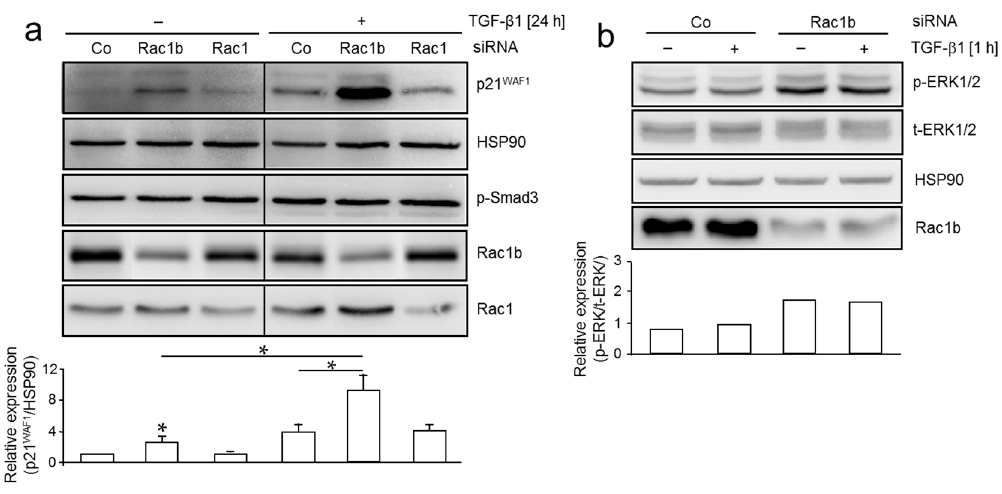
Figure 2. Depletion of Rac1b in MDA-MB-231 cells increases TGF- β -induced p21 WAF1 expression and ERK1/2 phosphorylation. ( a ) MDA-MB-231 cells were transiently transfected twice at two consecutive days with 50 nM of either a control siRNA (Co), a Rac1b-specific siRNA, or a Rac1-specific siRNA not cross-reactive with Rac1b. Twenty-four h after the second transfection, cells were starved (0.5% FBS) overnight and subsequently treated in the same medium with TGF- β 1 for 24 h followed by immunoblot analysis of p21 WAF1 , phospho-Smad3 (p-Smad3), and HSP90 as loading control. Successful depletion of Rac1b and Rac1 protein was verified with a Rac1b-specific antibody and a Rac1 antibody, respectively. Onerepresentative blot is shown withall bands being from the same blot. The vertical lines between lanes of control and TGF- β -treated samples indicate removal of irrelevant lanes. The graph below the blot depicts results from a densitometric analysis using NIH Image J of underexposed replicates from three independent experiments (mean ± SD, n = 3). * p < 0.05; ( b ) MDA-MB-231 cells were transiently transfected twice at two consecutive days without transfection reagent alone (-), or with 50 nM of either a control siRNA (Co), or a Rac1b-specific siRNA and further processed as described in ( a ) except that treatment with TGF- β 1 was for 1 h. Immunoblots were incubated with antibodies to phospho-ERK1/2 (p-ERK1/2), total-ERK1/2 (t-ERK1/2), and Rac1b and HSP90 as controls. The immunoblot shown is representative of three independent